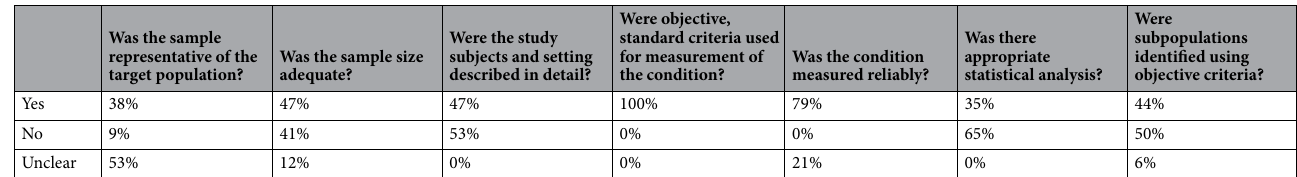
Table 3. Results of appraisal tool questions for prevalence